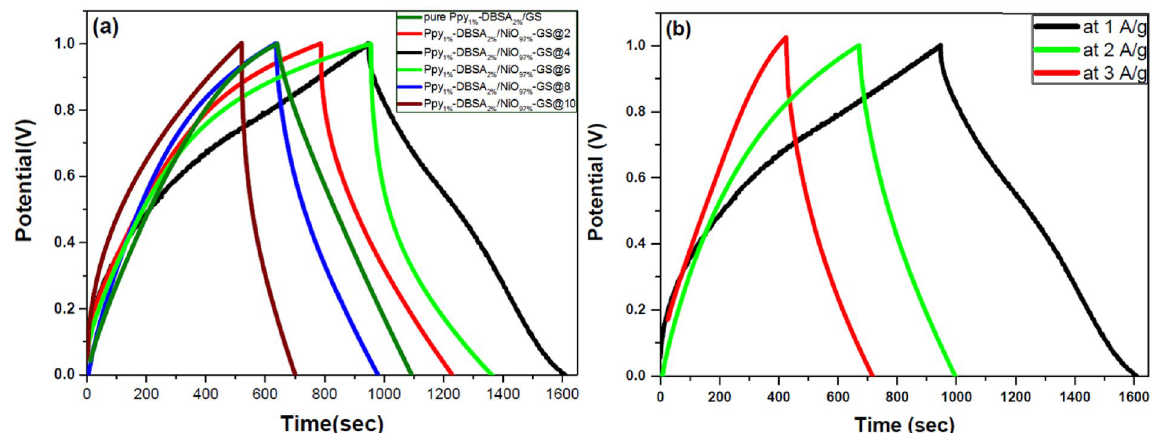
Figure 6. GCD curves of ( a ) pure Ppy 1% -DBSA 2% /GS and Ppy 1% -DBSA 2% /NiO 97% -GS nanocomposite electrodes at 1 A g −1 and ( b ) Ppy 1% -DBSA 2% /NiO 97% -GS@4 at different